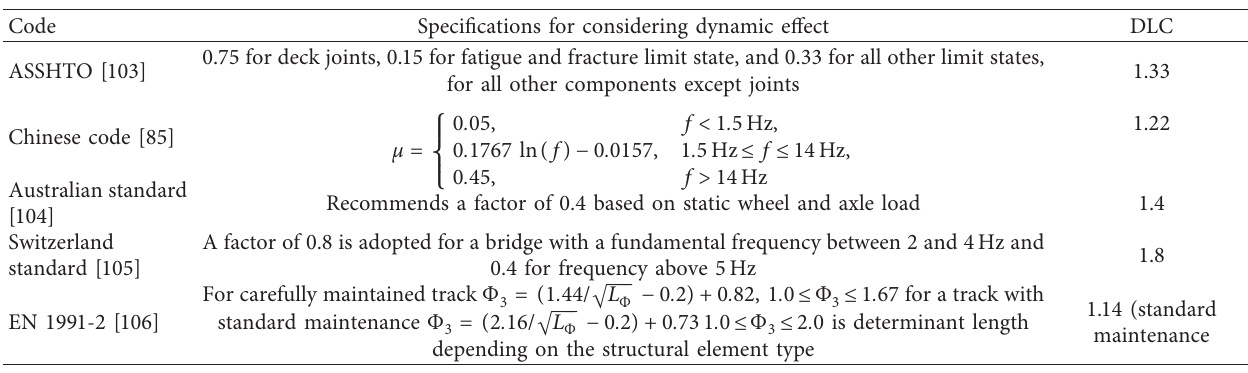
Figure 20: Peak dynamic load coefficient of the front wheel and rear wheel. Table 5: Recommended DLC based on technical specifications from different